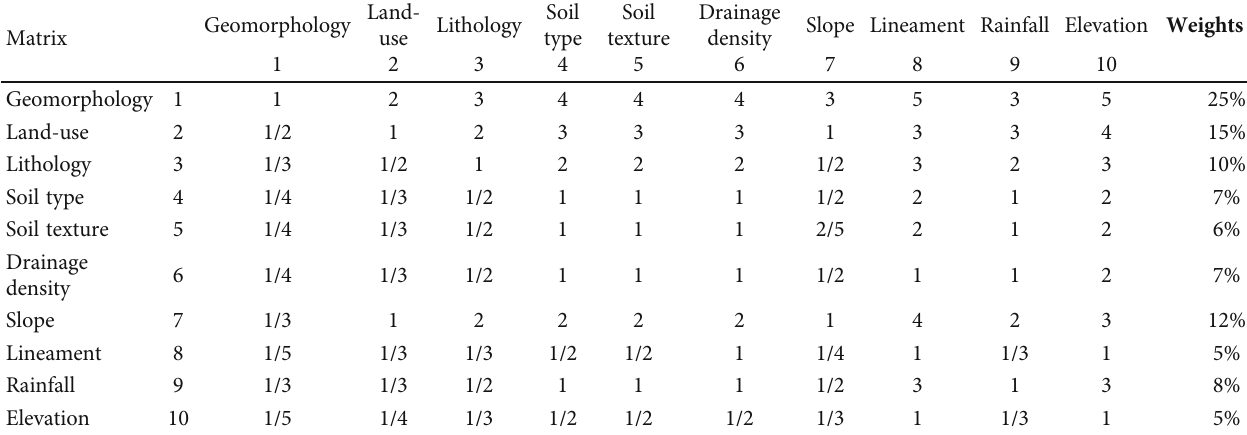
Table 4: Comparison matrix and signi fi cance weightage value of the in fl uential factors.